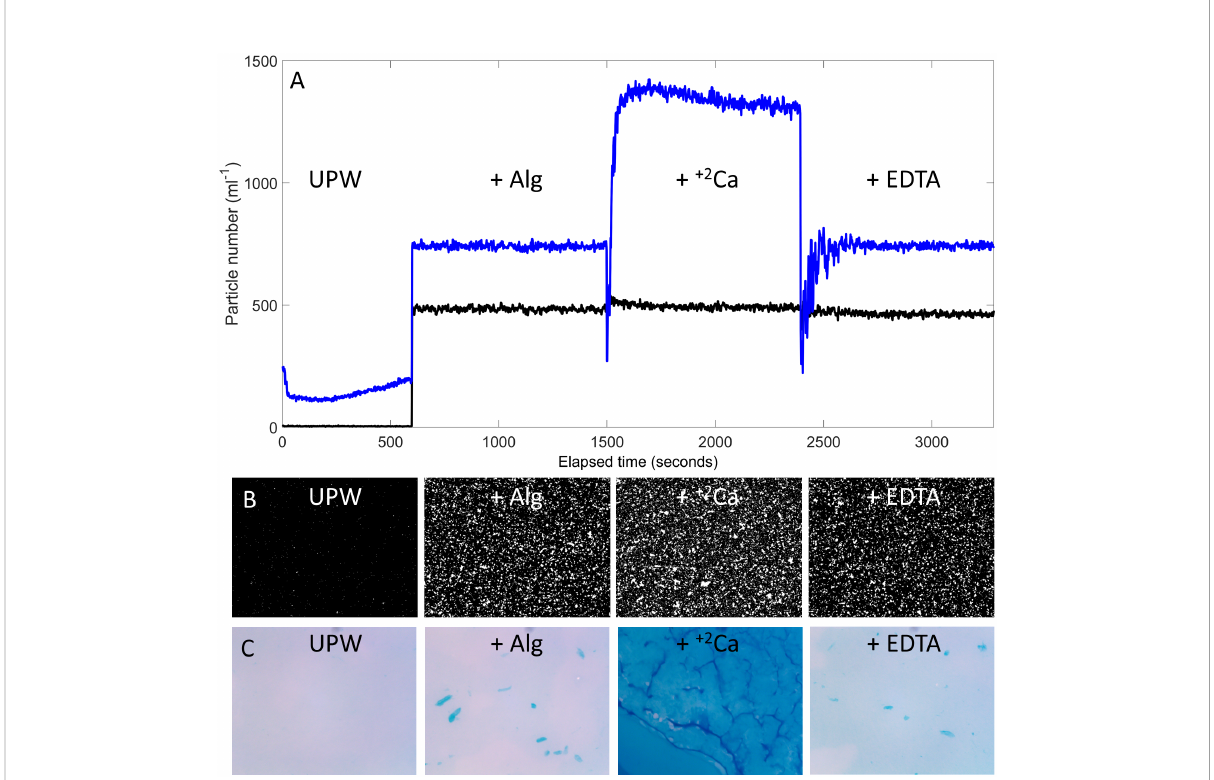
FIGURE 2 Laboratory experiments with alginates as models of aquatic gels. UPW = ultra-pure water (18.2 M W .cm), + Alg = solution of sodium alginates in UPW. Images are stacked up vertically in the time series. (A) Coagulation and dissolution dynamics of the gels due to the addition of calcium ions (+ +2 Ca) and EDTA (+ EDTA), respectively, were only visible at a lower threshold (Th = 7, blue) and not at higher threshold (Th = 15, black). The short-lived decreases in particle numbers immediately after the chemical additions were due to temporary obfuscation of particles by schlieren effects caused by the different osmolarities of the liquids (Davidhazy, 2006) (B) Binarized example images during the course of the experiment (Th = 7 only). (C) During this sequence, Alcian blue staining of subsamples of water during the experiment shows the buildup of a thick gel layer on the fi lter due to cation bridges (due to the calcium addition), and dissolution after the addition of